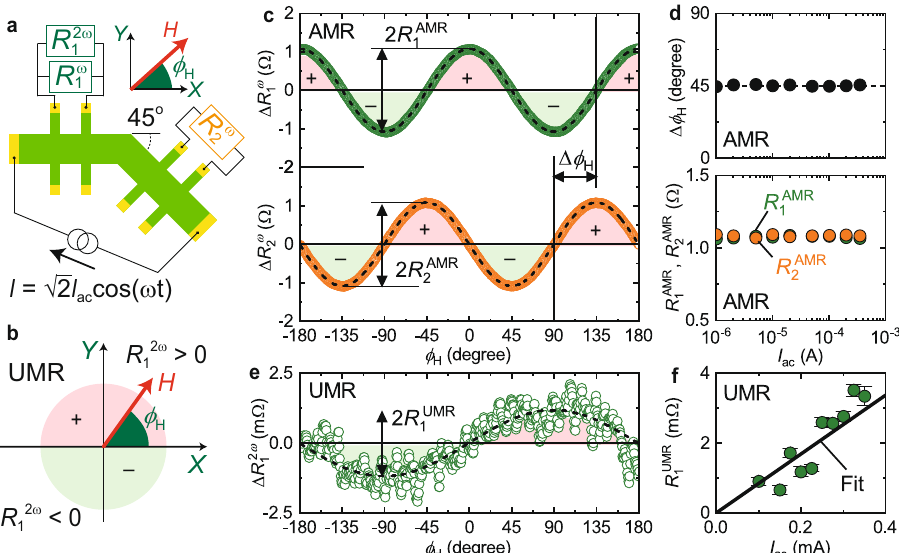
rotation of the magnetic fi eld. The Fig. 3 AMR and UMR measurements for determination of θ H . a Top view of measurement setup. b Schematic of ϕ H UMR signal measured in R 2 ω produces a positive value for 0° < ϕ < 180° (red region) while it produces a negative value for − 180° < ϕ < 0° (green). c ϕ H H H 1 H = 1 T was rotated in the xy plane. The measurement was performed at I = 0.2 mA dependences of Δ R ω (green circles) and Δ R ω (orange circles) when μ ac 1 2 0 and f = 13 Hz. d Current amplitude ( I ac ) dependence of the phase shift of ϕ ( Δ ϕ ) between the AMR signals, de fi ned by the horizontal arrow in ( c ), and H H H = 1 T was rotated in AMR signal R AMR (green circles) and R AMR (orange circles), de fi ned by the vertical arrows in ( c ). e ϕ dependence of Δ R 2 ω when μ 1 2 1 H 0 the xy plane. f I ac dependence of UMR signal R UMR de fi ned as vertical arrows in ( e ). Error bars denote the interval with the 95% reliability. 1